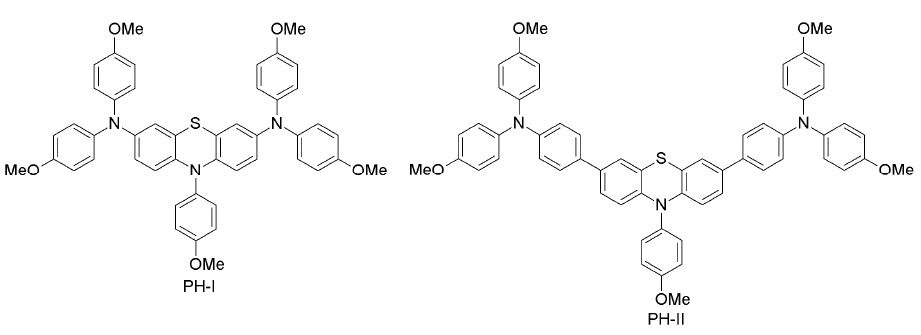
Figure 7. Phenothiazine-based HTMs.